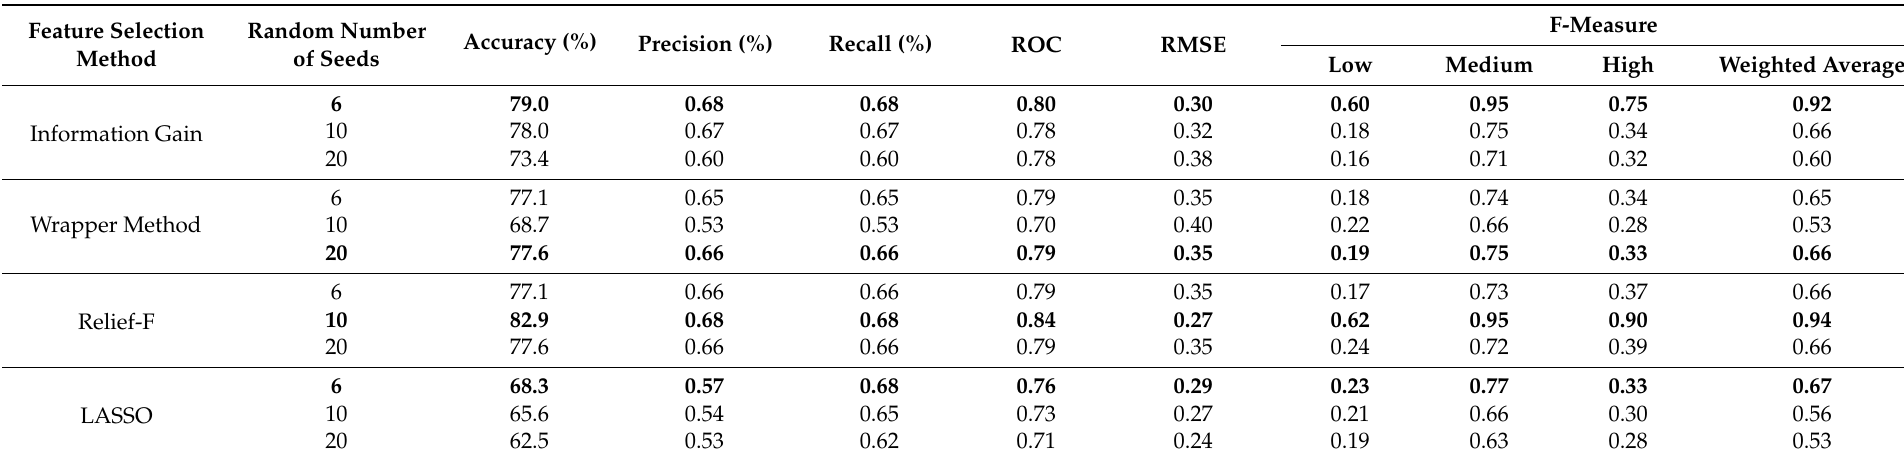
Table 8. Performance of multiclass neural network through various feature selection